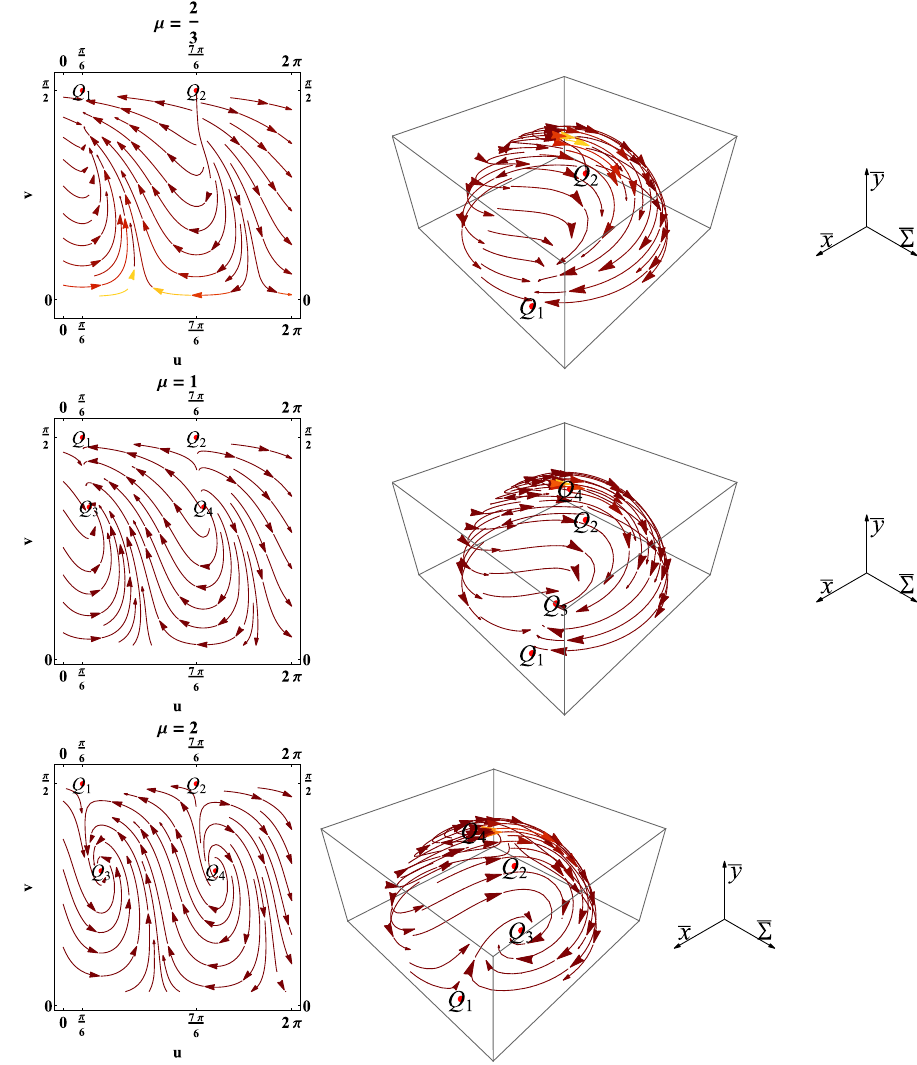
Fig. 2 Dynamics of the stationary points at infinity of system (55) and (56) in the plane ( u ,v) (left panels) and the projection over the Poincarè sphere ¯ x = cos u sin v, ¯ (cid:15)